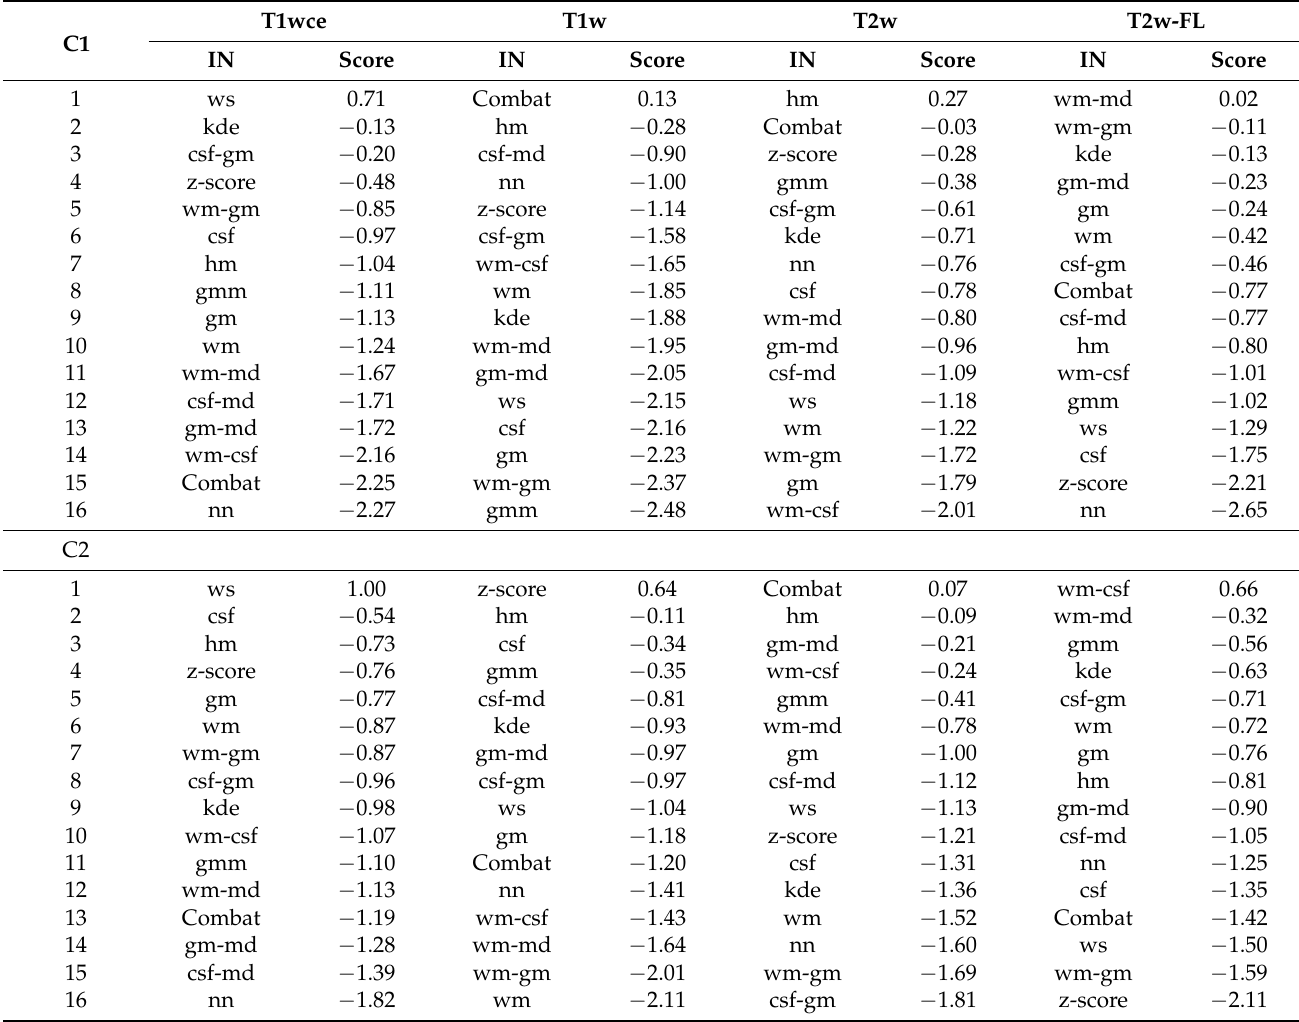
Table 3. Ranking with scores of the intensity normalizations of the MR sequences for cohorts C1 and C2. T2w-FL: T2w-FLAIR, IN: Intensity normalization method.